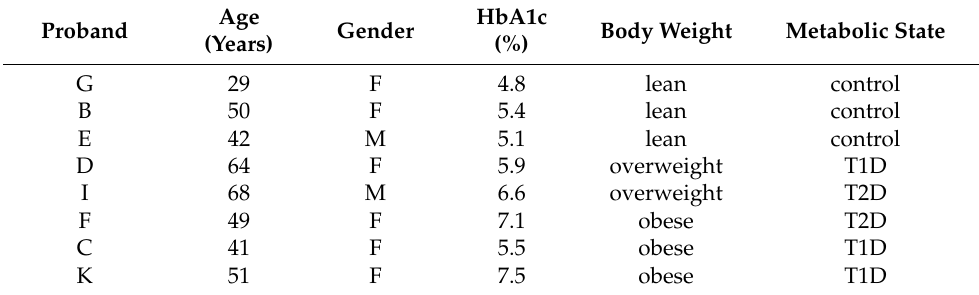
Table 2. Characteristics of the human probands. HbA1c levels of controls (B, G, E) and type 1 diabetic (T1D; C, D, K) and type 2 diabetic (T2D; F, I) patients of various age, gender (F, female; M, male), body weight, and metabolic state are